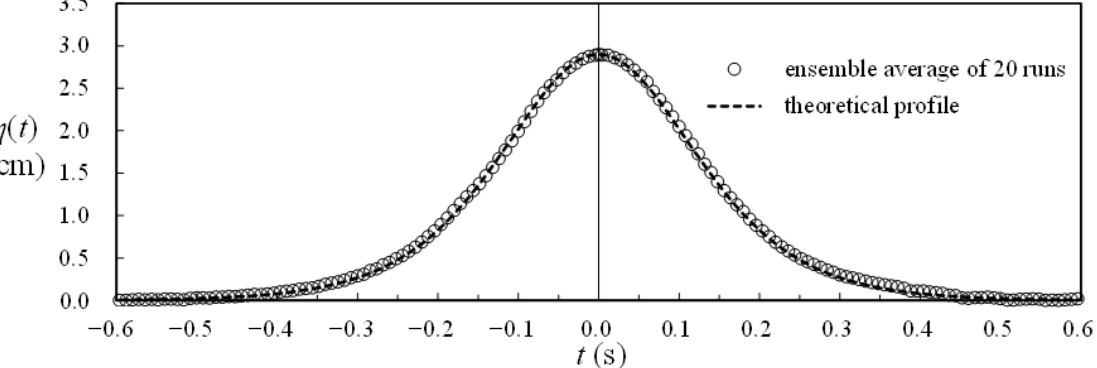
Figure 3. A comparison of time series between ensemble-averaged free surface elevation η ( t ) and predicted one (Case E).